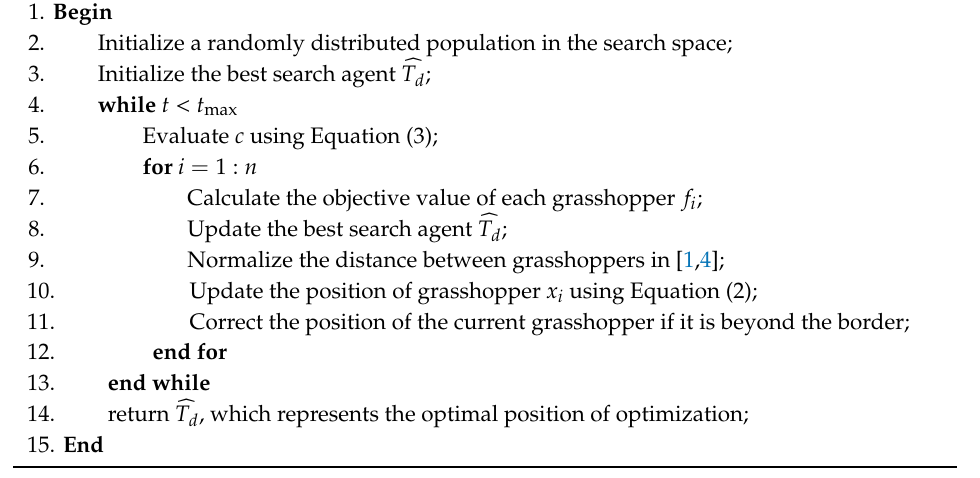
Algorithm 1 Pseudocode of grasshopper optimization algorithm for optimization